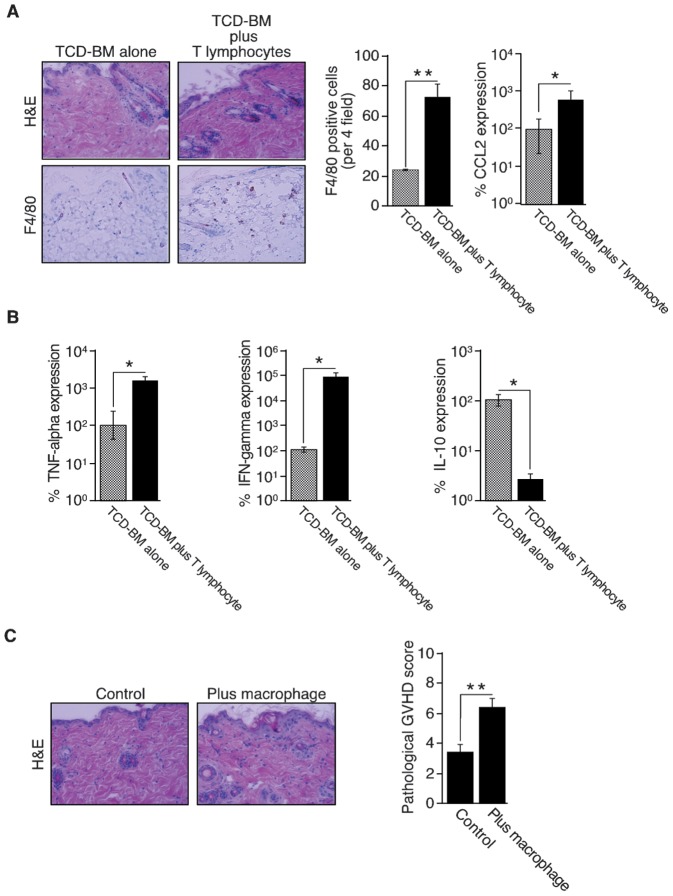
Characterization of macrophage-involvement in GVHD.
A: Skin specimens from mice in which T-cell depleted bone marrow (TCD-BM) cells and spleen-derived T lymphocytes were co-transplanted were histopathologically compared with those of mice transplanted with TCD-BM alone. Skin specimens (7 days after transplantation) were stained with H&E (upper left panels) and macrophages were detected with the anti-mouse F4/80 monoclonal antibody (lower left panels). Original magnification, ×400. Representative images of two independent experiments are shown. For quantitative analysis of macrophage numbers, 4 microscopic fields were randomly selected from each of three mice and the total number of F4/80+ cells was counted. The mean number of F4/80+ cells per 4 fields ± SD is shown for each group (middle panel). Original magnification, ×200. The results are representative of two independent experiments. Statistical significance: **P<0.01. CCL2 mRNA expression was evaluated using quantitative real-time RT-PCR. Total RNA was extracted from the skin (3 specimens per group) and was subjected to RT-PCR using specific primer pairs. Each reaction was performed in duplicate sets. The obtained data were normalized to internal eukaryotic 18 s rRNA expression, were analyzed using the 2−ΔΔCT Method and are expressed as percent expression, where expression of the control is designated as 100%. The results reflect the mean ± SD of three independent determinations. The results are representative of two independent experiments. Statistical significance: *P<0.05. B: Macrophages in the skin were characterized by measurement of TNF-α, IFN-γ and IL-10 mRNA expression. Skin dermis was incubated in RPMI containing 2% Liberase for 2 h at 37°C. After digestion, residual tissue was minced and mechanically disaggregated. After separation of dermal macrophages by using the magnetic isolation system, total RNA was extracted and mRNA levels of TNF-α, IFN-γ and IL-10 were quantified by RT-PCR using specific primer pairs (3 specimens per group). Each reaction was performed in duplicate sets. The obtained data were normalized to internal eukaryotic 18 s rRNA expression, were analyzed using the 2−ΔΔCT Method and are expressed as percent expression, where expression of the control is designated as 100%. The results reflect the mean ± SD of three independent determinations. Statistical significance: *P<0.05. The results are representative of two independent experiments. C: Direct effects of inflammatory macrophages on GVHD were assessed by injecting thioglycolate-stimulated macrophages (1×106 cells per mouse) or PBS (three mice per group) subcutaneously into the interscapular region of GVHD mice 5 days after BMT. The animals were killed 7 days after BMT. Skin specimens of the injected sites stained with H&E were photographed (left panel) and skin GVHD was pathologically scored based on five parameters (epidermal damage, alteration of dermis, degree of inflammation, alteration of subcutaneous fat and number of follicles). The results reflect the mean ± SD of three independent determinations. Statistical significance: **P<0.01. The results are representative of two independent experiments.